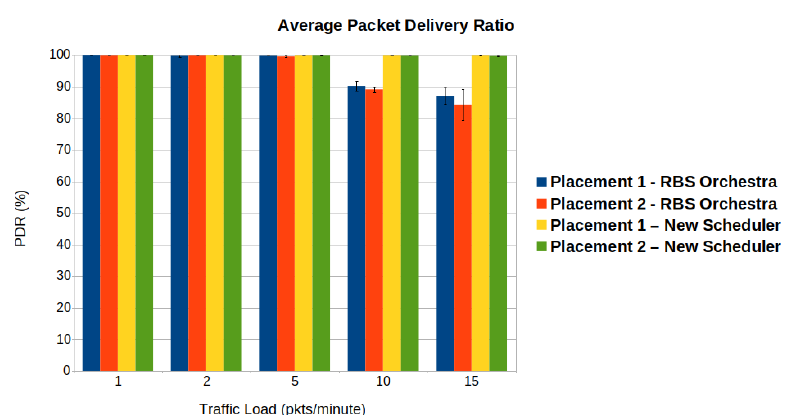
Figure 9. We observe that when it comes to average packet delivery ratio (PDR), the new scheduler performs better than Orchestra, in high traffic